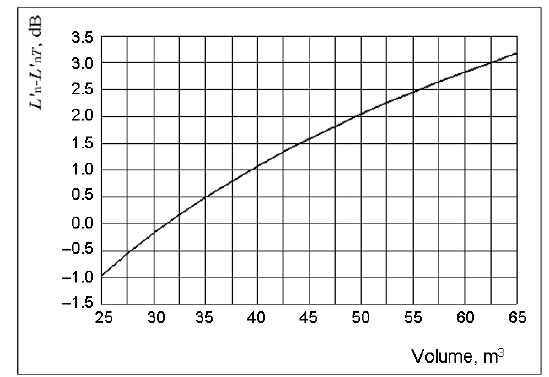
Fig. 4. Dependency of the difference L ’ n – L ’ n T from receiving room’s volume (modified from Jagniatinskis, Fiks